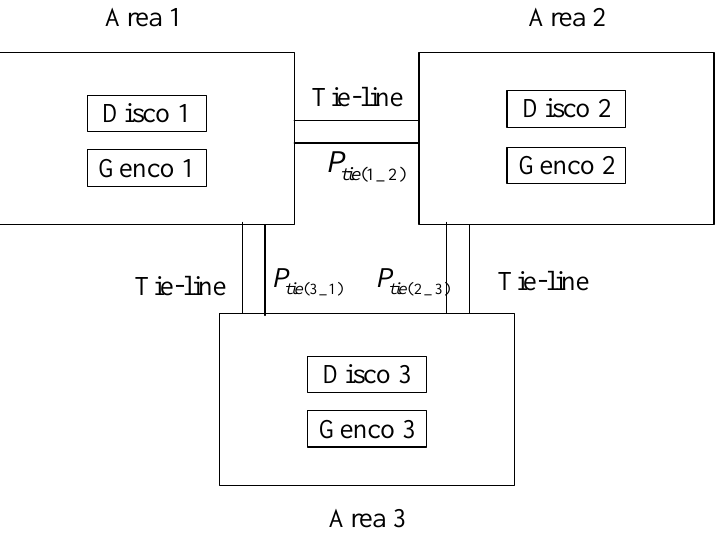
Figure 8. Diagram of a ring network containing three